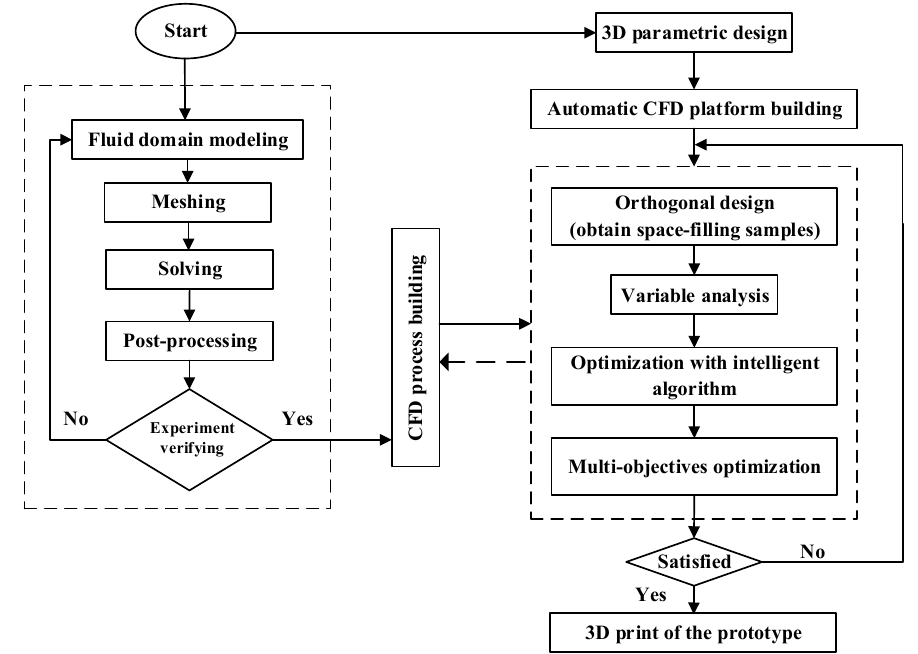
Figure 1. The flowchart of optimization process. CFD, computational fluid dynamics.